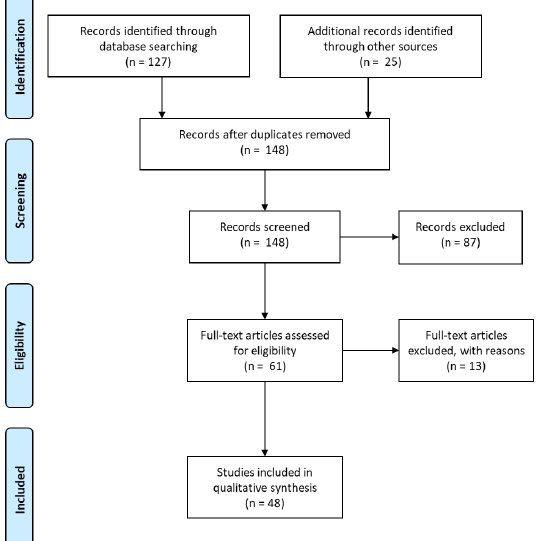
Figure 1. PRISMA flow chart